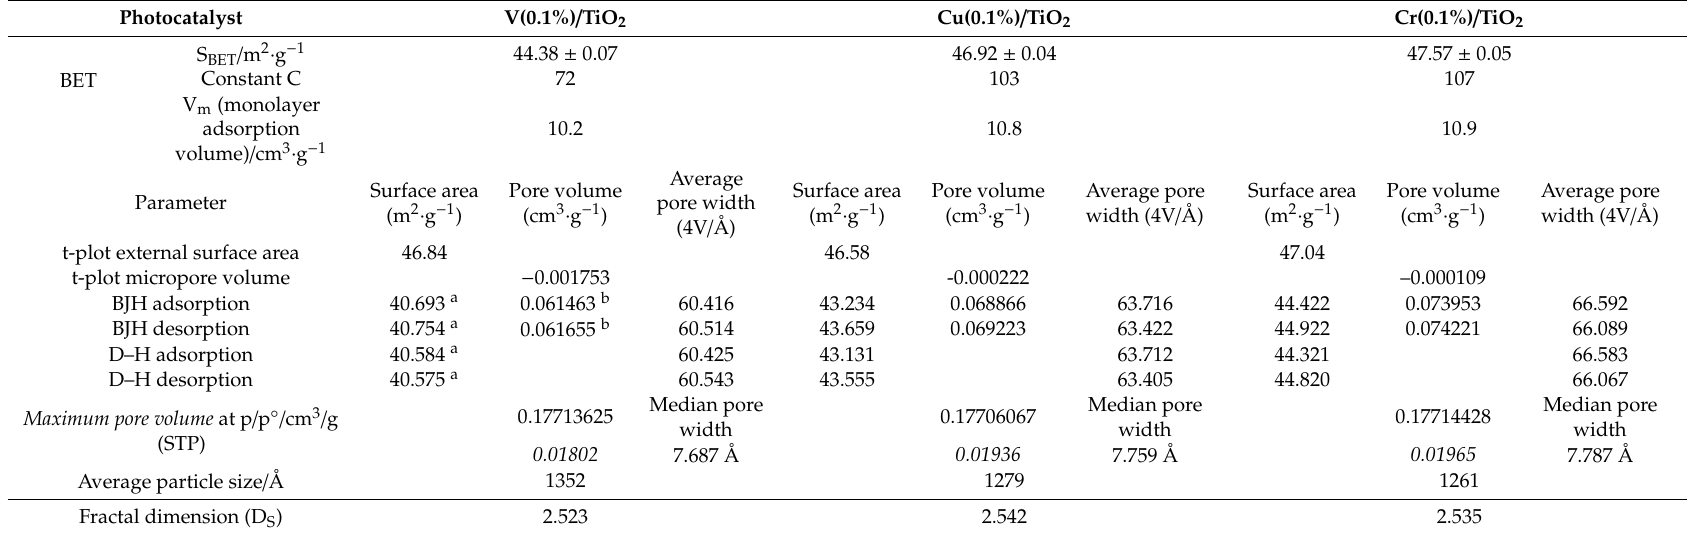
Table 3. BET parameters and textural properties of V(0.1%) / TiO 2 , Cu(0.1%) / TiO 2 and Cr(0.1%) / TiO 2 photocatalysts measured by N 2 adsorption–desorption. TiO 2 -P25 BET surface area = 51 (m 2 · g − 1 )